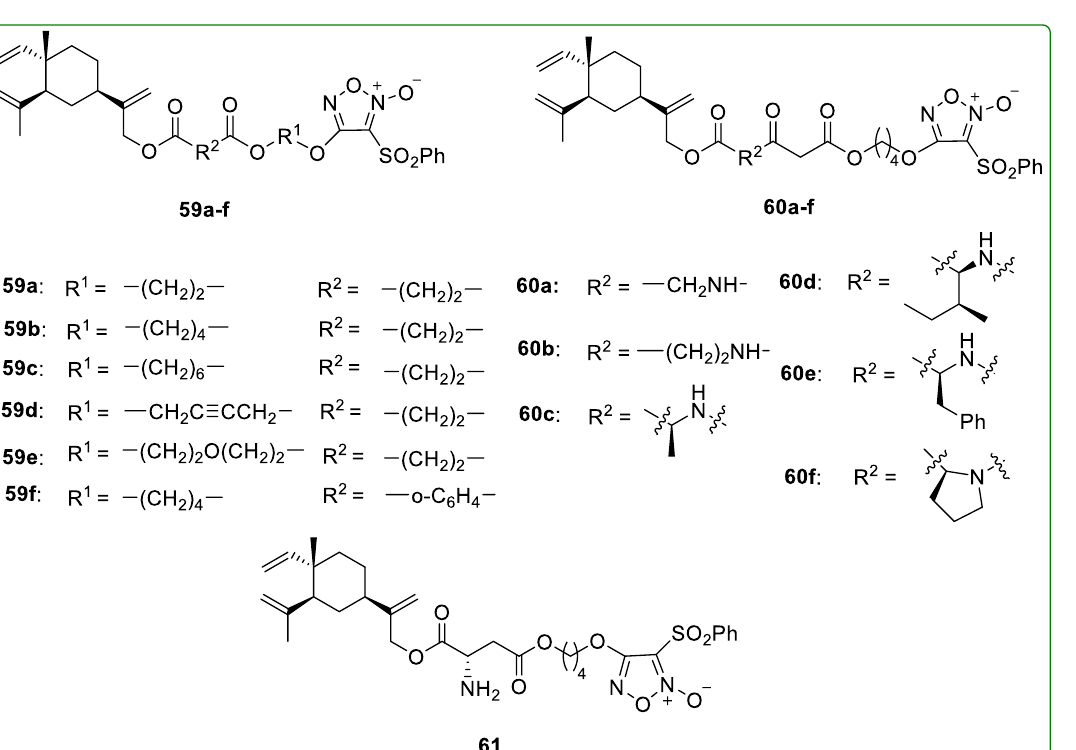
Figure 19. Chemical structures of radioactive derivatives 53 – 58 .